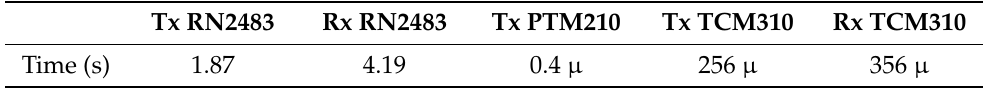
Table 9. Amount of time until enough energy is